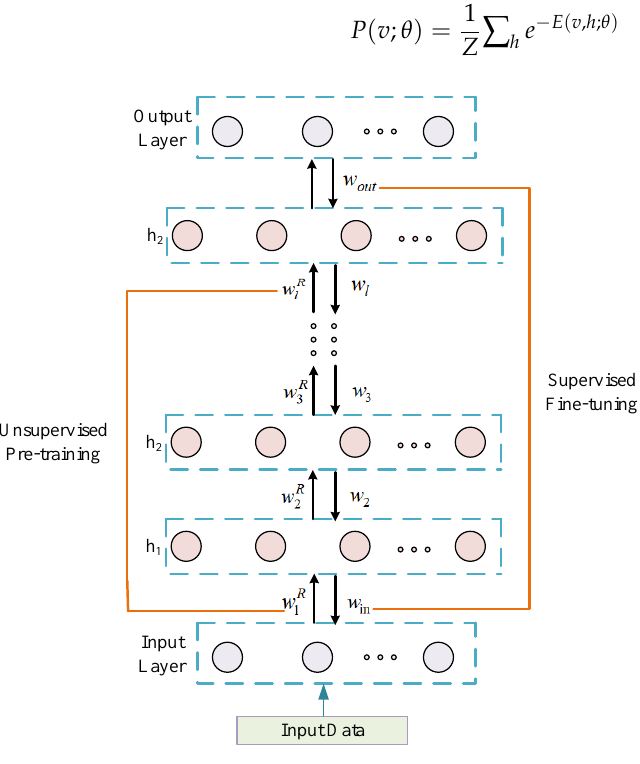
Figure 2. Structure of DBN.